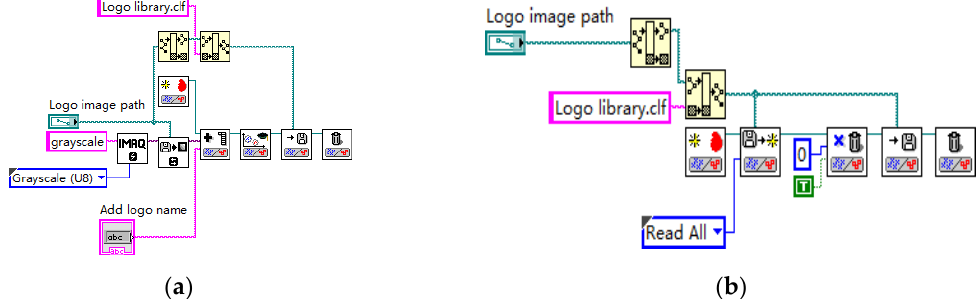
Figure 7. Program block diagram. ( a ) creation of library files and ( b ) deletion of the library files.